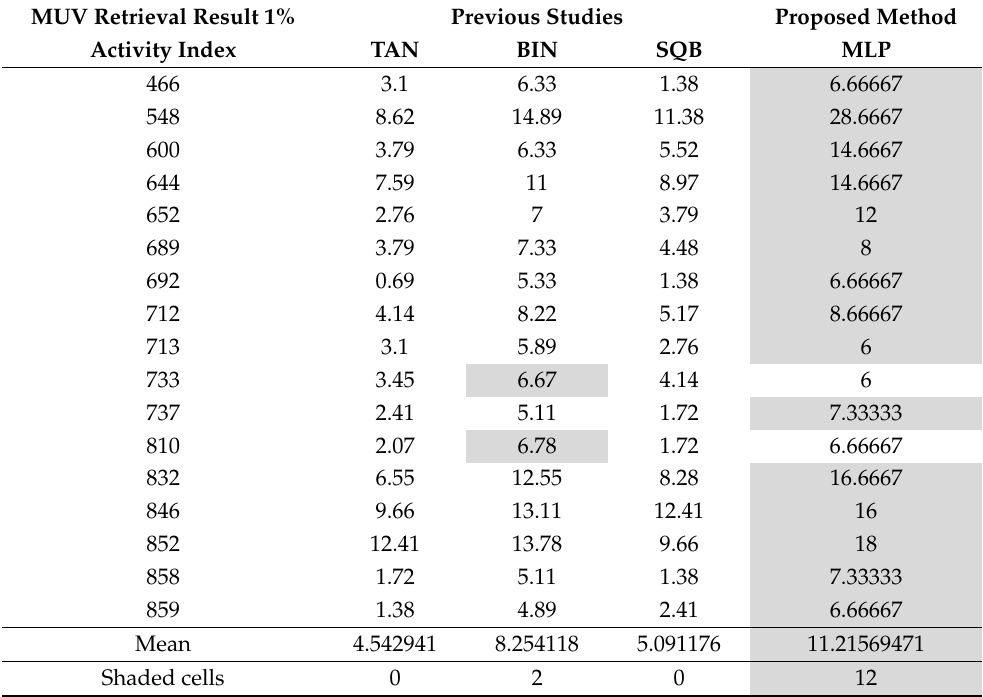
Table 12. Top 1% retrieval results for MUV dataset for descriptor (ECFC 4).